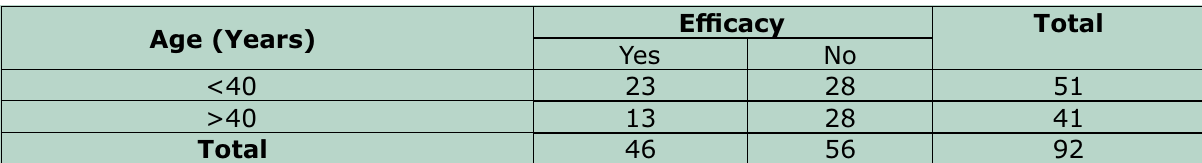
Table-II: Comparison of age with efficacy